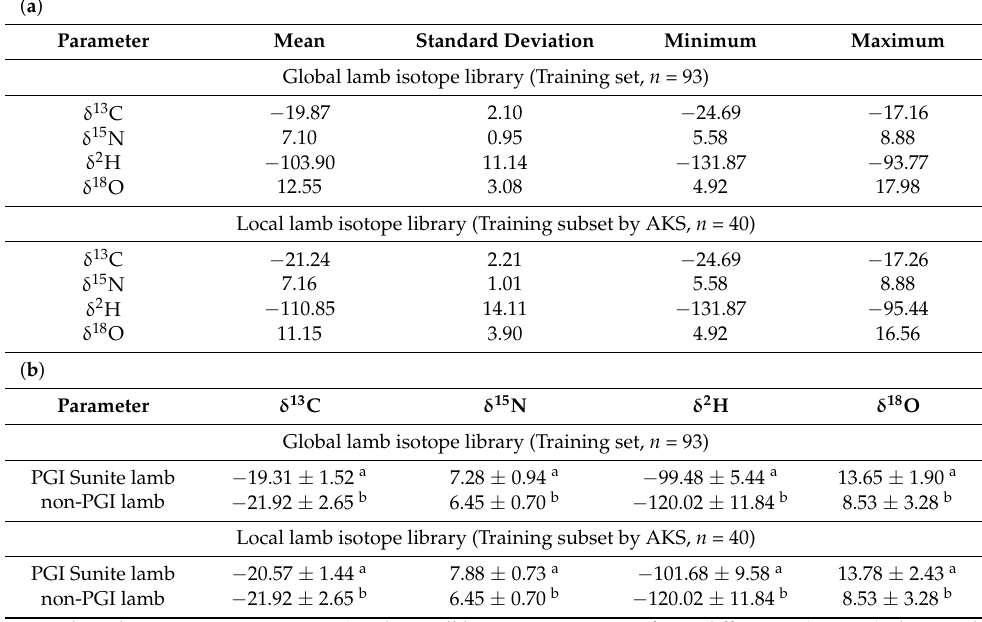
Table 2. ( a ) Descriptive statistics of the isotope attributes of samples in the lamb isotope libraries. ( b ) δ 13 C, δ 15 N, δ 2 H, and δ 18 O values of the local and global lamb isotopes libraries from two